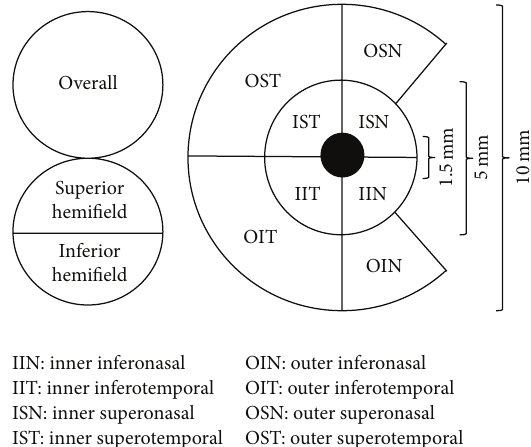
Figure 2: Ganglion cell complex (GCC) thickness map of the right eye in OCT-HS100 Glaucoma 3D algorithm. The area bounded by the inner (1.5 mm) and middle (5 mm) circles forms the inner ring, while the area bounded by the middle (5 mm) and outer (10mm) circles forms the outer ring. Thicknesses are averaged for the overall measurement, superior and inferior hemifields over the 10mm diameter circle, and inner (macular GCC) and outer (perimacular GCC) subfields. The section of the nasal outer ring that encroached onto the optic disc and the central 1.5mm in diameter area are